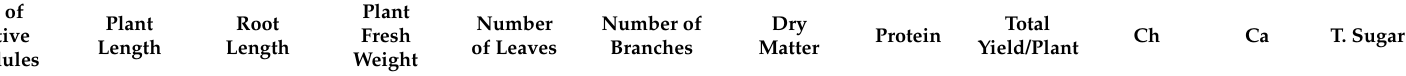
Table 3. Correlation coefficients among measured growth and yield